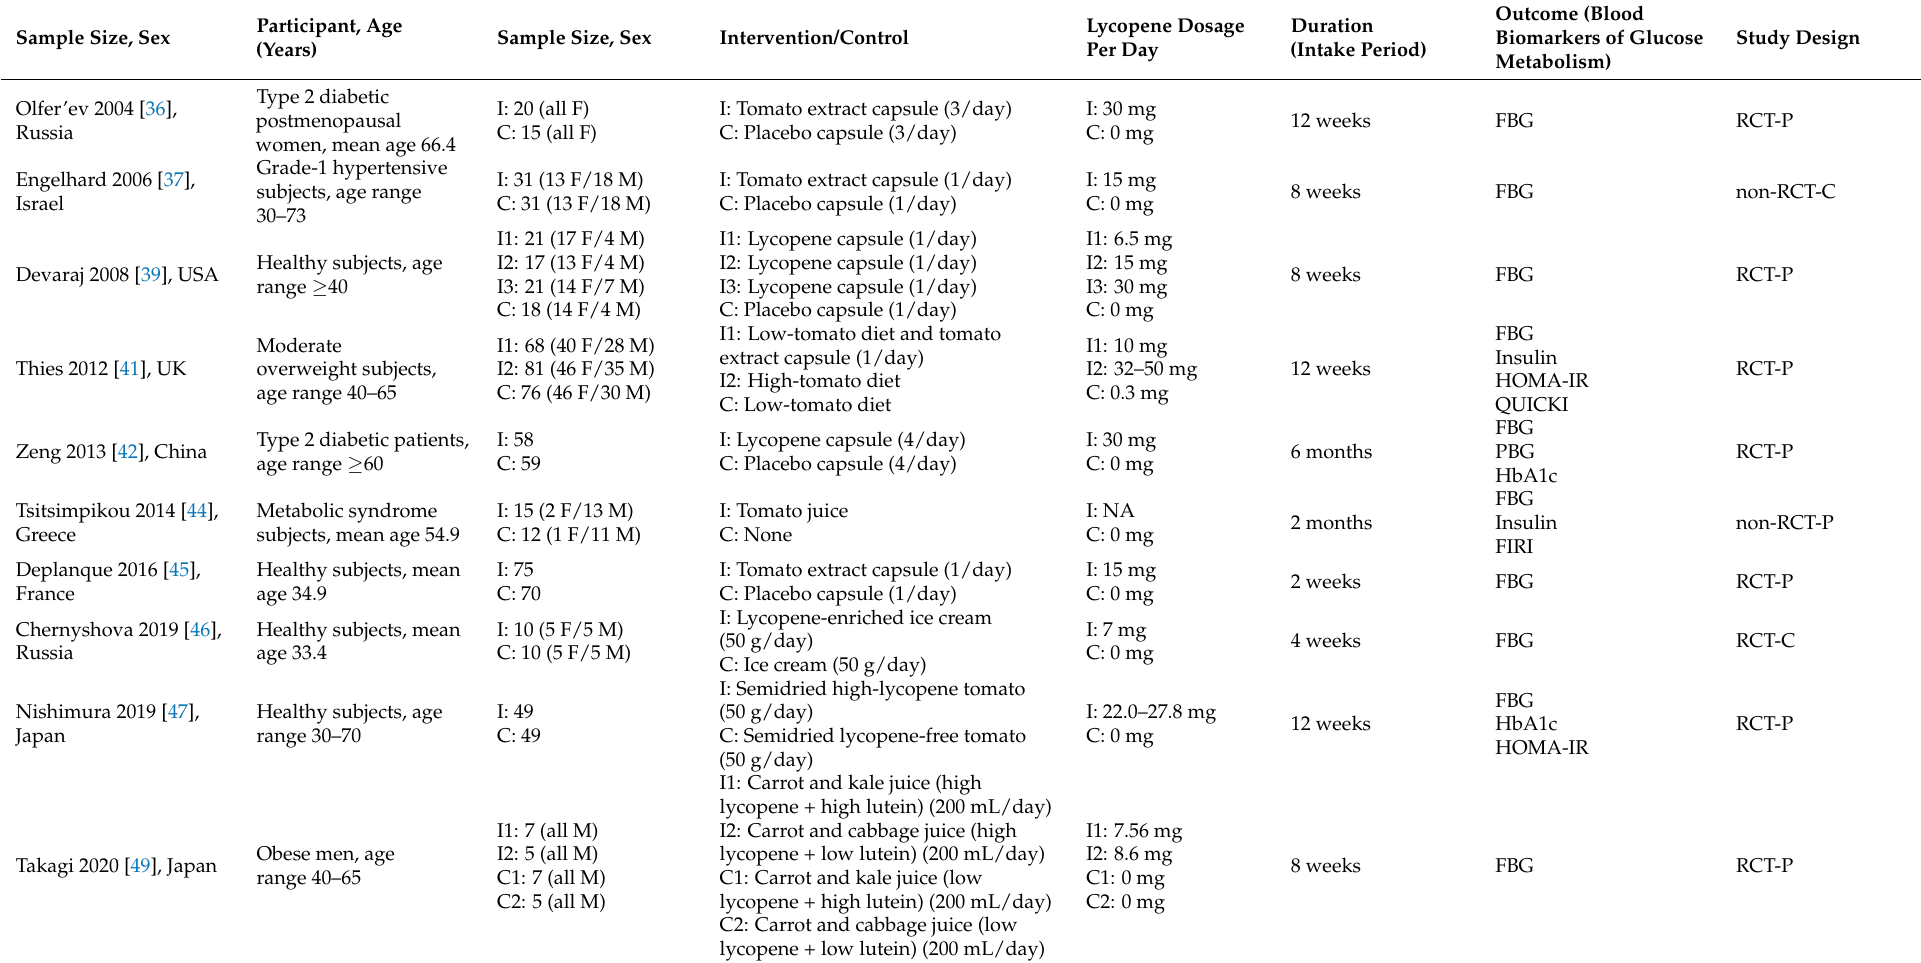
Table 2. Characteristics of the included